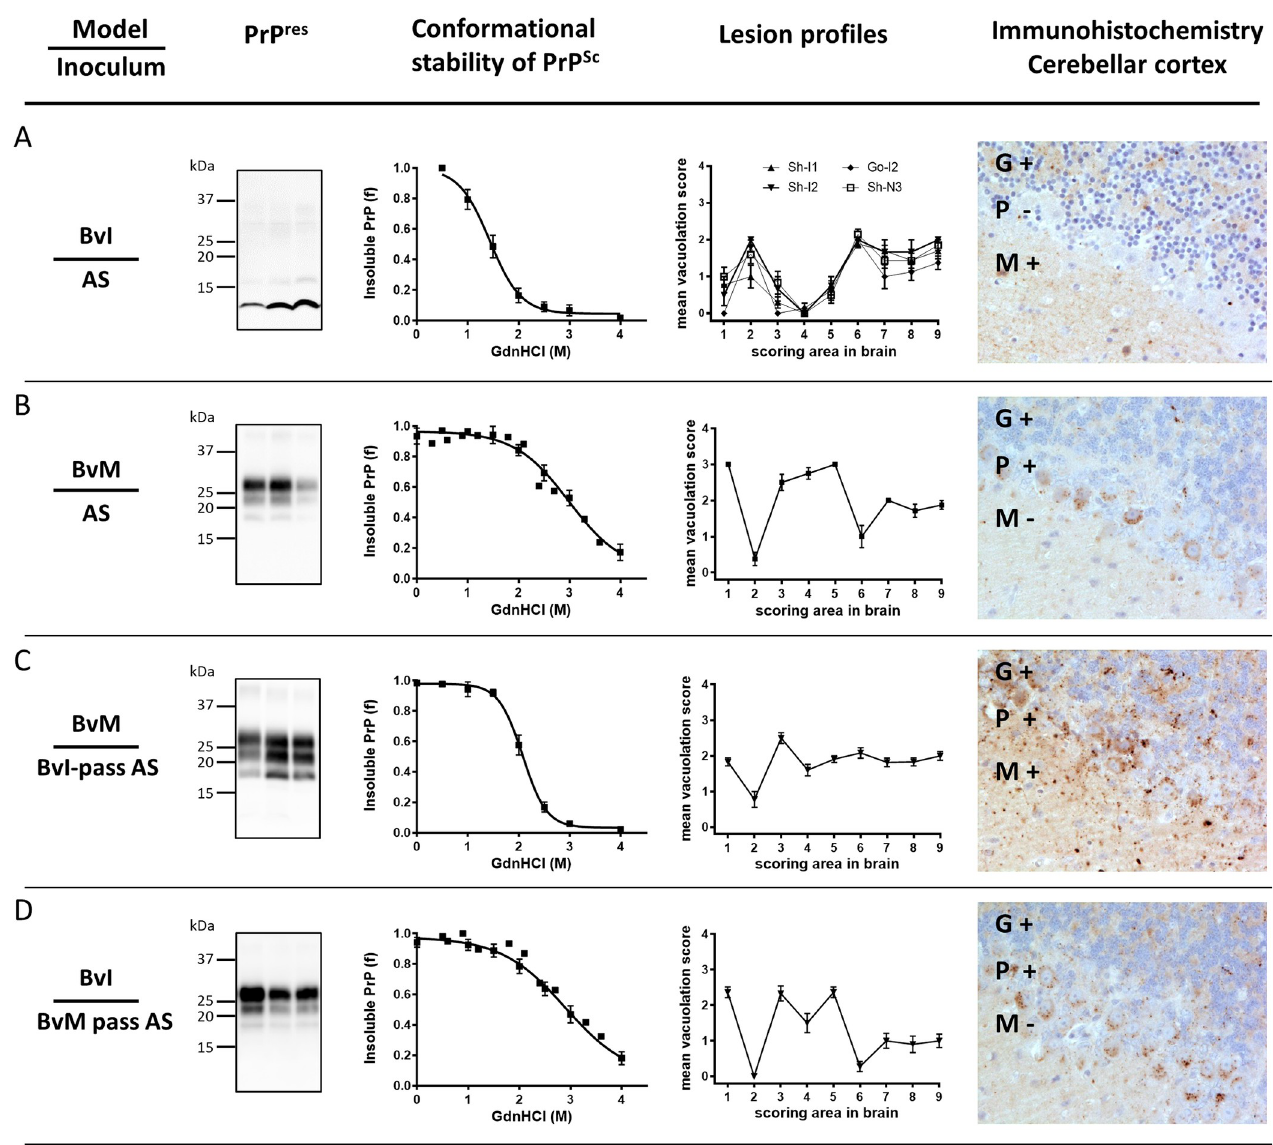
Fig 2. Transmission phenotypes in BvI and BvM infected with AS isolates. Biochemical properties of PrP Sc (PrP res typing and conformational stability) and neuropathological patterns (lesion profiles and immunohistochemistry for PrP Sc ) in BvI inoculated with AS (A) or BvM-passaged AS (D) and in BvM inoculated with AS (B) or BvI-passaged AS (C), as indicated in the left column (model/inoculum). Western blots in the second column (PrP res typing) show PK-treated PrP Sc from representative brains of voles. In A, C and D the first lane was loaded with samples from first passages; all other samples were from second passage experiments. The positions of MW markers are indicated on the left of the blots (in kilodaltons). Membranes were probed with mAb 9A2. The conformational stability of PrP Sc (third column) was analyzed by denaturation with increasing concentration of GdnHCl, followed by a solubility assay. The fraction of insoluble PrP Sc was plotted as a function of GdnHCl concentration (M) and best-fitted using a four parameter logistic equation. Error bars represent the SEM of at least three animals per group: in A the curve merges two groups from different first passages (Sh-I1 and Sh-N3), while graphs in B, C and D show data derived from second passage experiments. Lesion profiles showing spongiform degeneration in groups of AS infected voles after primary transmission (A and D) or second passage (B and C). Data points represent the mean ± SEM of at least five voles per group. Brain scoring areas: medulla [1], cerebellum [2], superior colliculus [3], hypothalamus [4], thalamus [5], hippocampus [6], septum [7], retrosplenial and adjacent motor cortex [8], and cingulate and adjacent motor cortex [9]. Immunohistochemical detection of PrP Sc in the cerebellar cortex was performed with SAF84 mAb. The presence of PrP Sc in the granular layer (G), Purkinje cells (P) and molecular layer (M) of cerebellum is indicated (+, positive; -, negative).